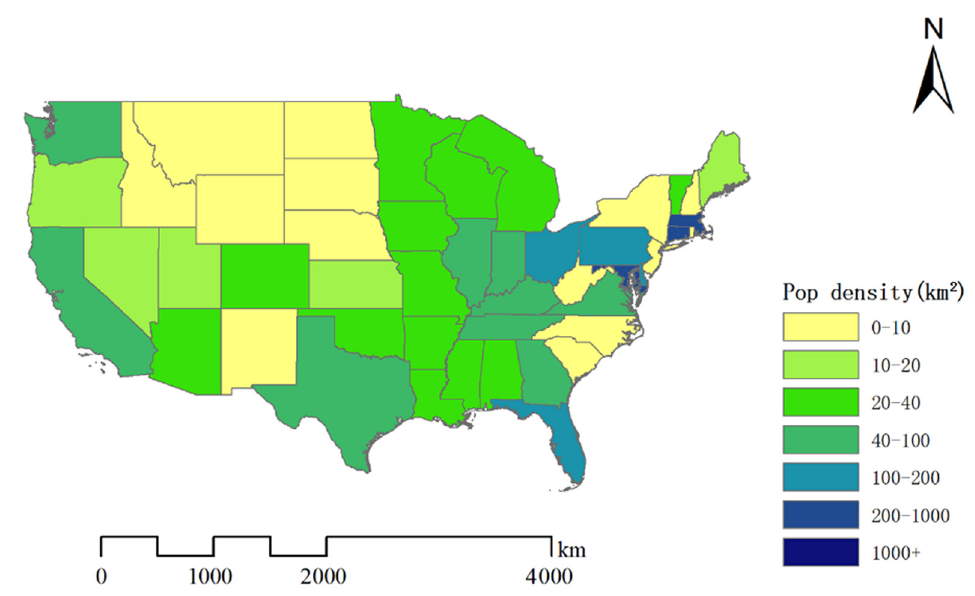
Figure 2. Map of population density by state in the United States. The map was created by ArcGIS software.